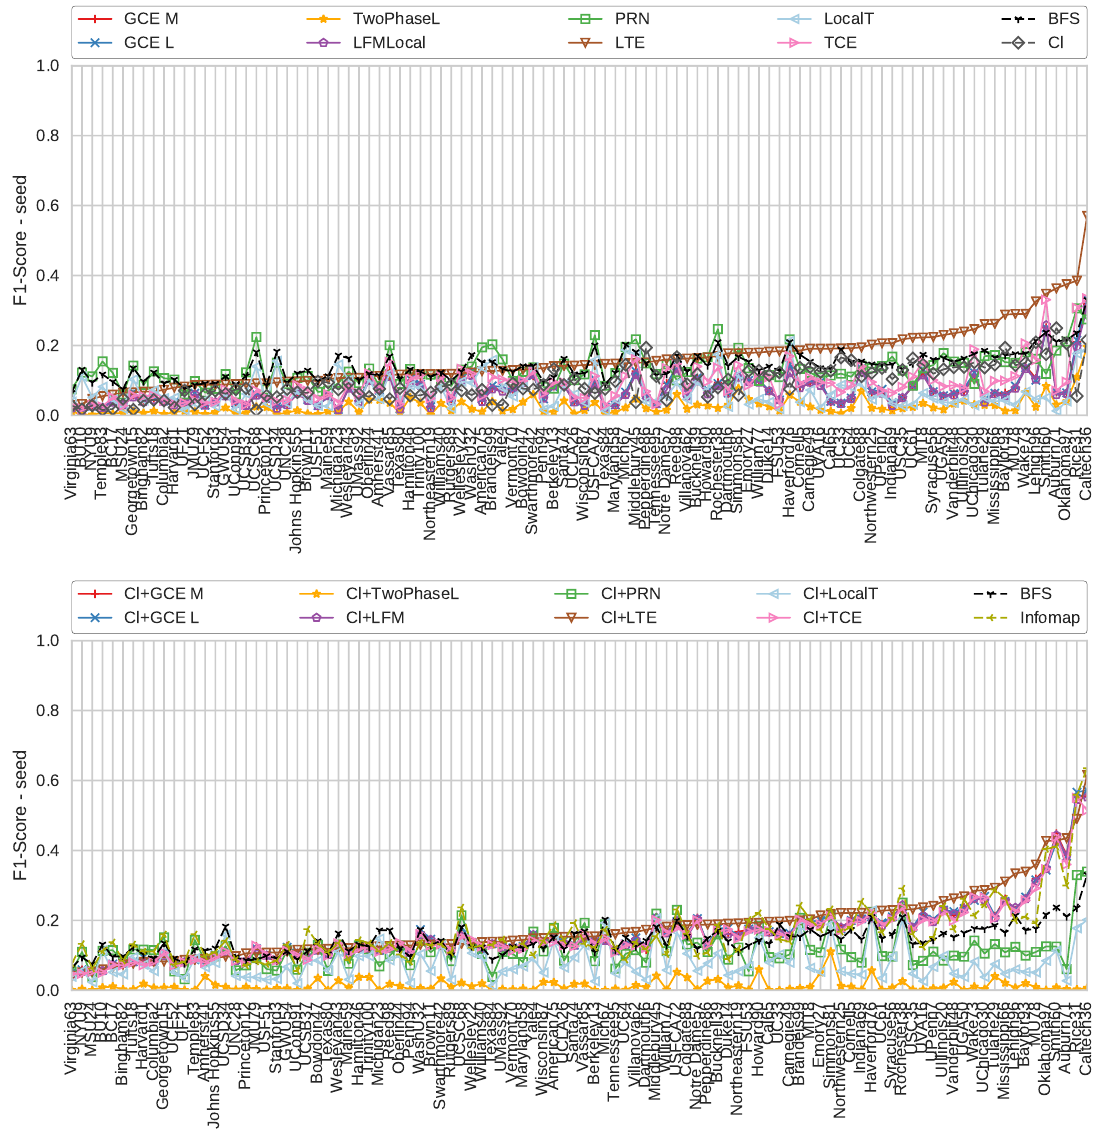
Figure 5. Average F 1 -scores of the algorithms on all 100 Facebook graphs. The scores are calculated by treating the dormitory attribute as communities. The graphs are sorted by the F 1 -score of